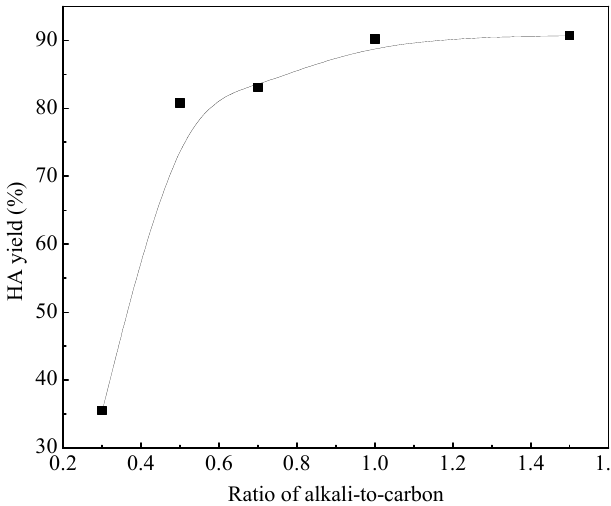
Figure 2. Effect of the alkali-to-carbon mass ratio on the HA yield.